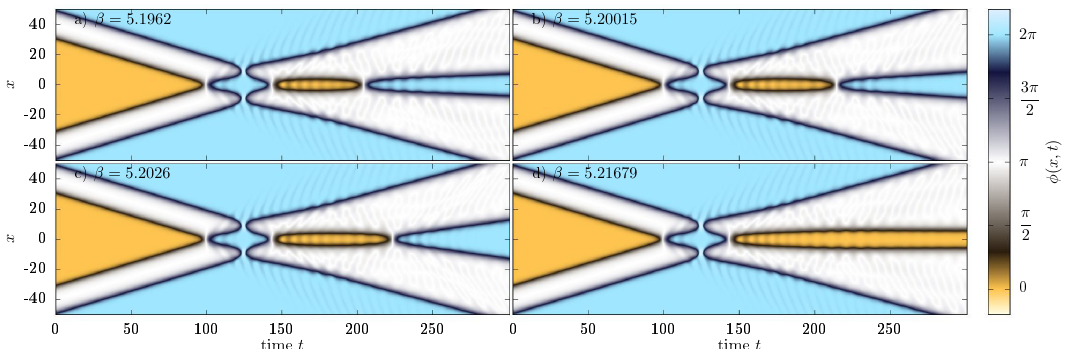
Figure 26 . Example collisions with initial velocity v = 0 . 3 for a variety of values of β . In the first three cases a subsequent resonant collision leads to the formation of a